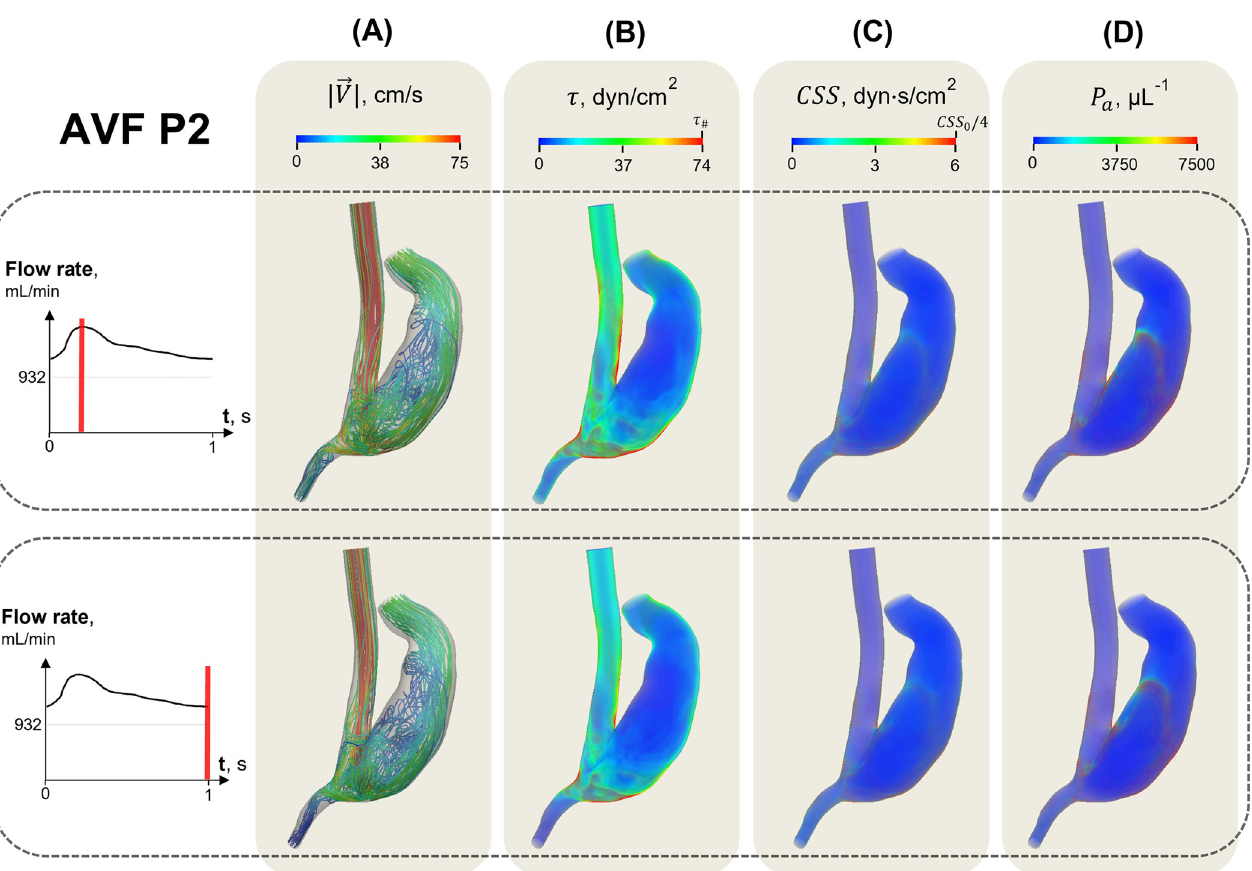
�� ! | (A), shear = 1300 mL/min, N = 100). The blue out